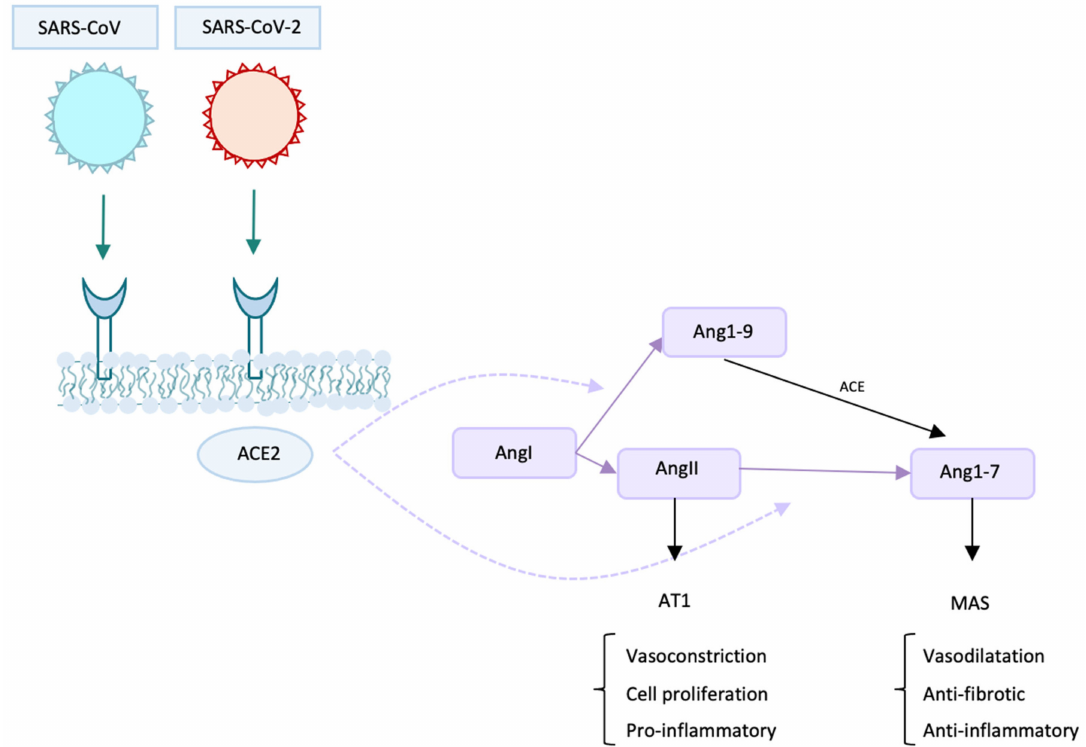
Figure 2. The main roles of ACE2 are shown in the figure. First, it is the cell-receptor for SARS-CoV and SARS-CoV-2. It is also a peptidase: it can create Ang1–9 starting from AngI and Ang1–7 from AngII. ACE2: angiotensin-converting enzyme 2. Ang: angiotensin. AT1: angiotensin II receptor type